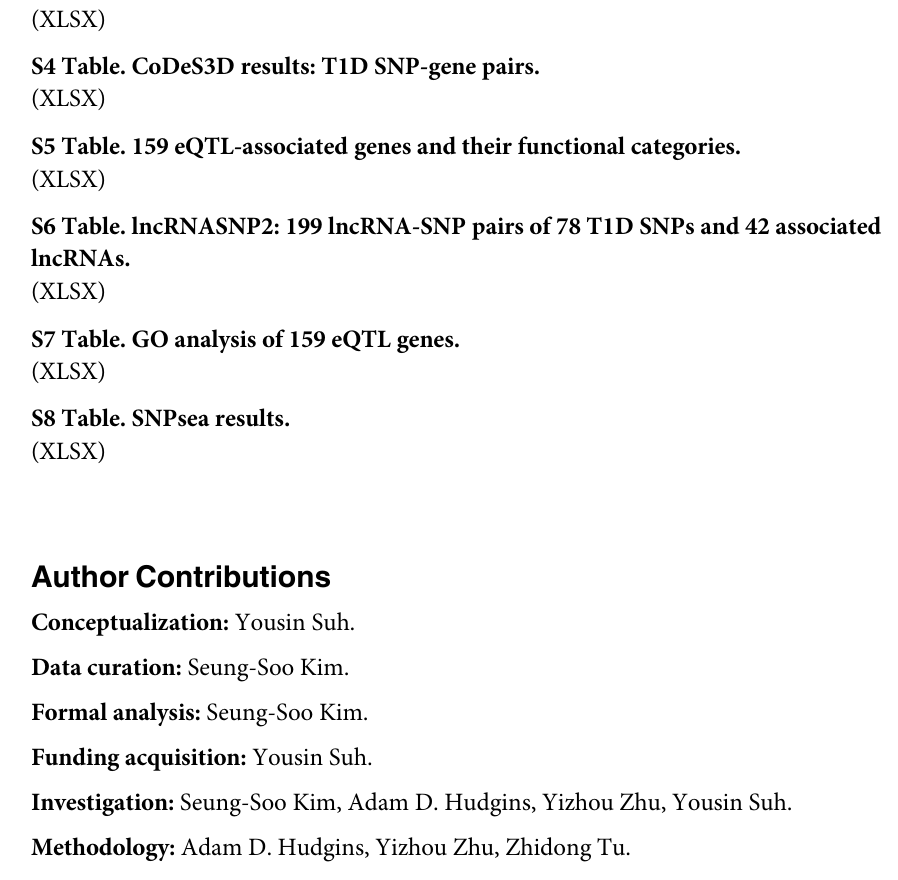
S2 Fig. Significant enrichment of T1D risk loci gene expression in CD4+ and CD8+ T cells. (PDF) S3 Fig. Expression changes of 35 genes associated with eQTLs affecting over 10 tissues. (PDF) S1 Table. Pairs of GWAS catalog SNPs and LDlink SNPs. (XLSX) S2 Table. Prioritization of 26 highest-probability SNPs. (XLSX) S3 Table. GTEx eQTLs and their associated genes as well as nearest genes associated with T1D SNPs. S4 Table. CoDeS3D results: T1D SNP-gene pairs. (XLSX) S5 Table. 159 eQTL-associated genes and their functional categories. (XLSX) S6 Table. lncRNASNP2: 199 lncRNA-SNP pairs of 78 T1D SNPs and 42 associated lncRNAs. (XLSX) S7 Table. GO analysis of 159 eQTL genes. (XLSX) S8 Table. SNPsea results.